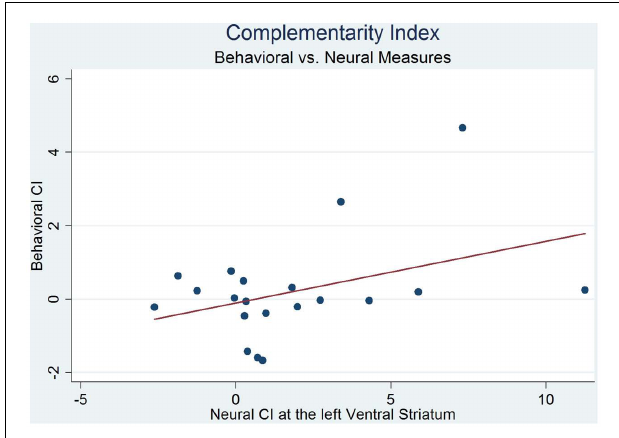
FIGURE 4 | BOLD data in the left ventral striatum exhibit positive interaction, or complementarity between responsibility and environment factors as measured by complementarity index CI = 1.82 (Wilcoxon signed-rank test, z = 2.46, p = 0.01), see Eq. 3 for definition of CI. The Figure shows that neural CI ( x -axis) predicts behavioral CI ( y